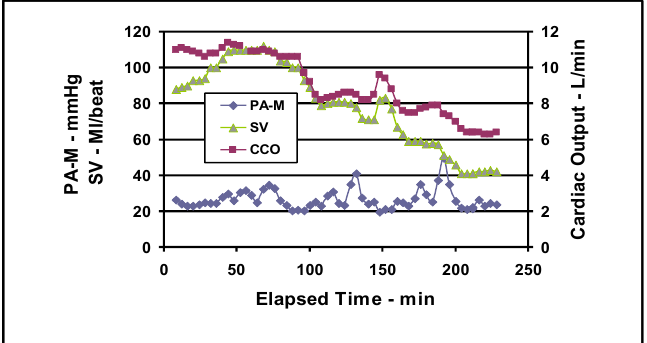
Figure 9. Mean pulmonary arterial pressure (PA-M), stroke volume (SV), and mean cardiac output (CCO) vs. elapsed time.